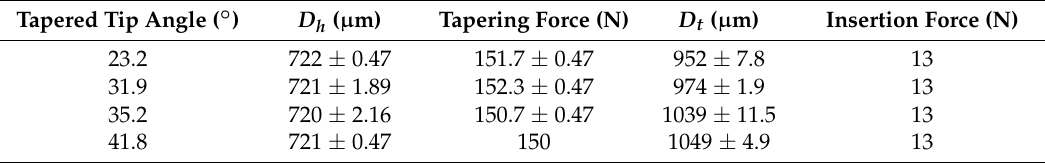
Table 1. Experimental conditions and measured diameters of drilled holes and tapered